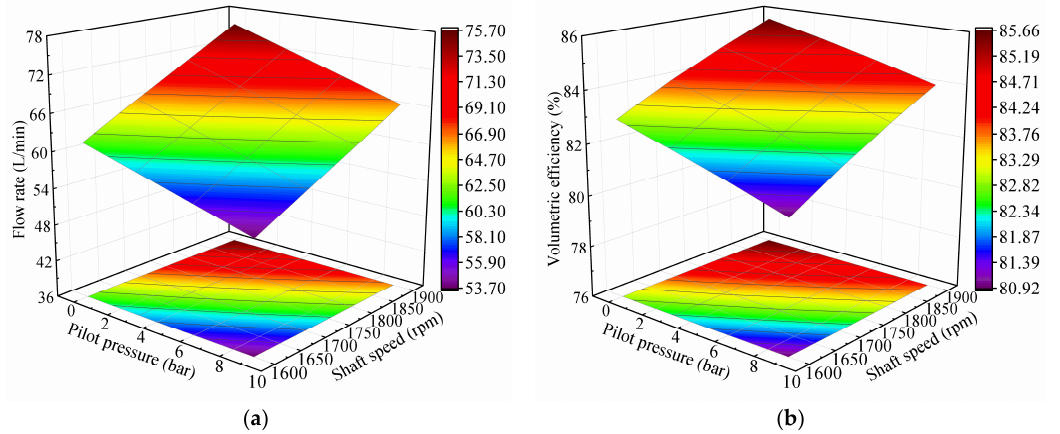
Figure 17. Output flow and volumetric efficiency of the double-compound axial piston pump: ( a ) outlet flow; ( b ) volumetric efficiency.